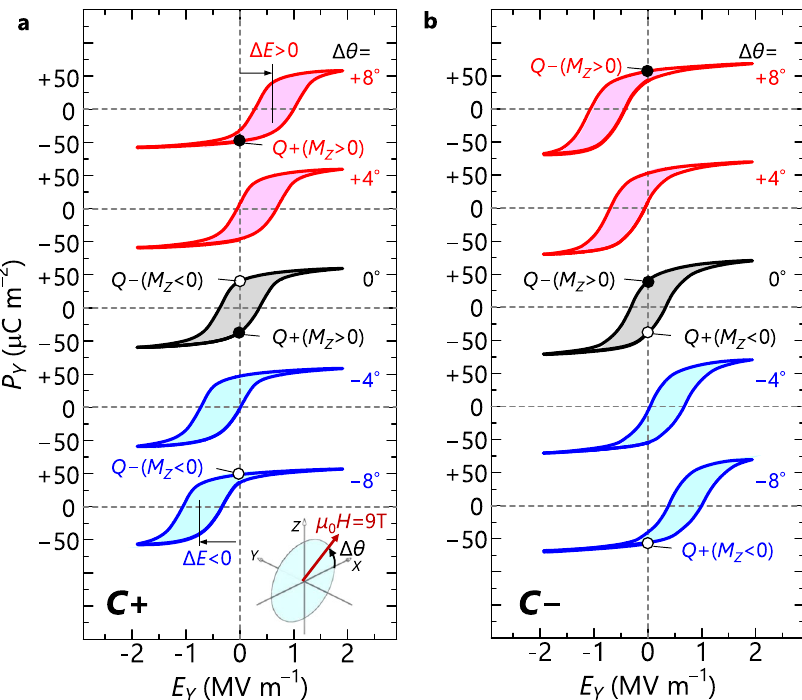
Fig. 4 Chirality-magnetism coupling as probed via ferroelectric hysteresis loops. a , b P Y E Y hysteresis loops for a C + and b C − crystals in an applied H tilted from the + X direction by an angle Δ θ of − 8° ≤ Δ θ ≤ + 8°. De fi nition of Δ θ is illustrated in the inset of a . In the fi nite H tilting, the ferroelectric hysteresis loops are shifted along the E Y axis by Δ E , whose sign depends on the sign of Δ θ as well as the chirality switching. The magnetic quadrupole domains ( Q + / Q − ) stabilized by the tilted H are indicated by the white and black circles, together with respective signs of orthogonal magnetization M Z